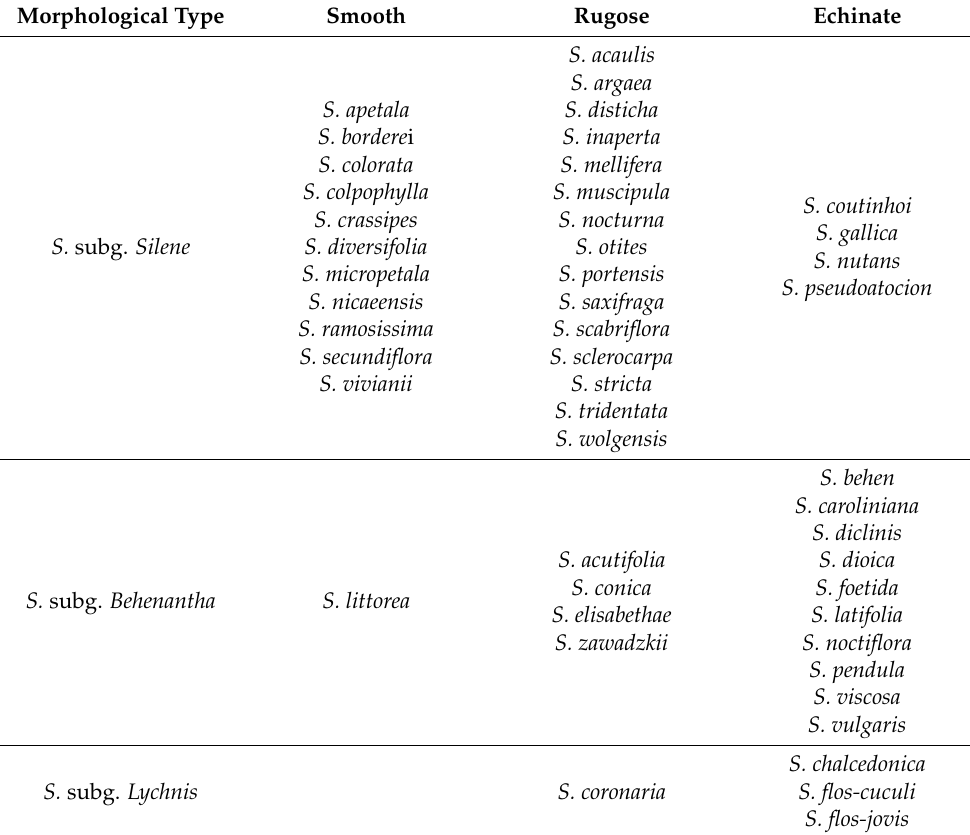
Table 2. Correlation between the three morphological groups of seeds and the taxonomical subgenera of Silene , according to